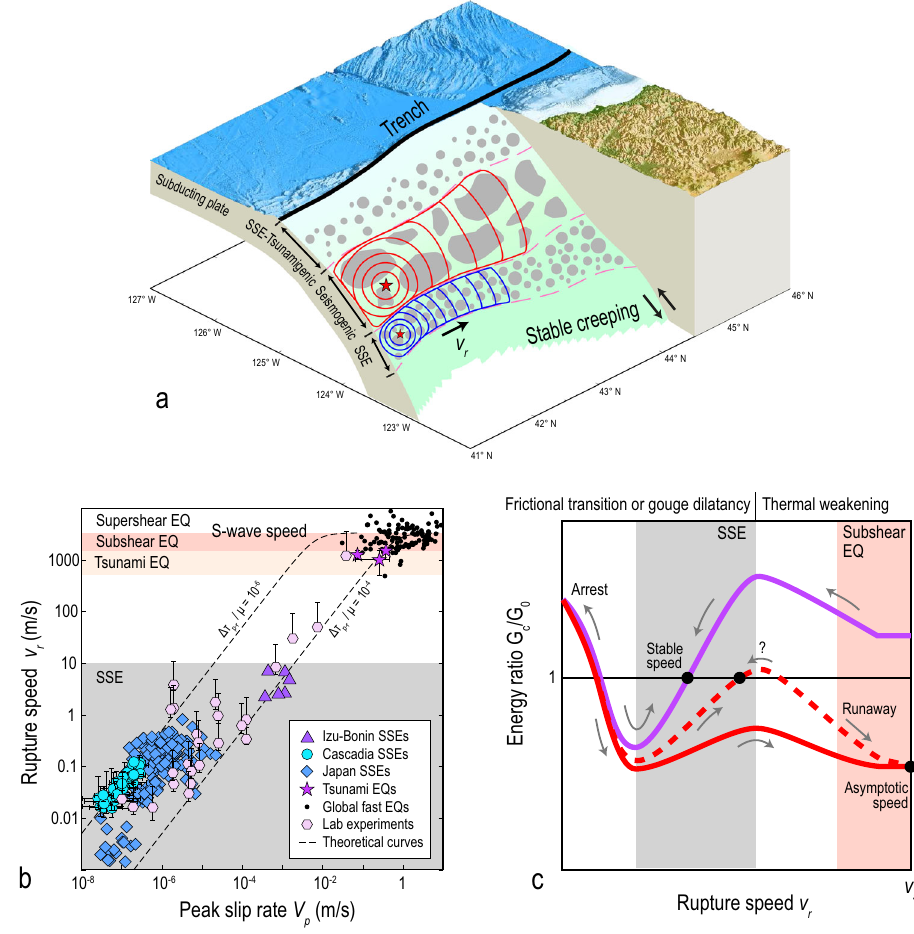
Fig. 1 | Slow and fast ruptures on a subduction zone and their rupture speeds. a Sketch of subduction zone composed of tsunamigenic, seismogenic and SSE zones with fi nite widths. Rupture propagation fronts of SSE (blue curves) and earthquake (red curves) start at the hypocenters indicated by red stars. Topo- graphy data is downloaded from the NOAA Data Catalog. b Symbols represent estimates of rupture speed versus peak slip rate of observed SSEs 14 – 16 , laboratory experiments 22 , tsunami earthquakes 17 – 19 and regular earthquakes 20,21 (error bar